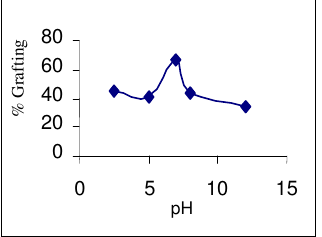
Figure 3f. Effect of pH on